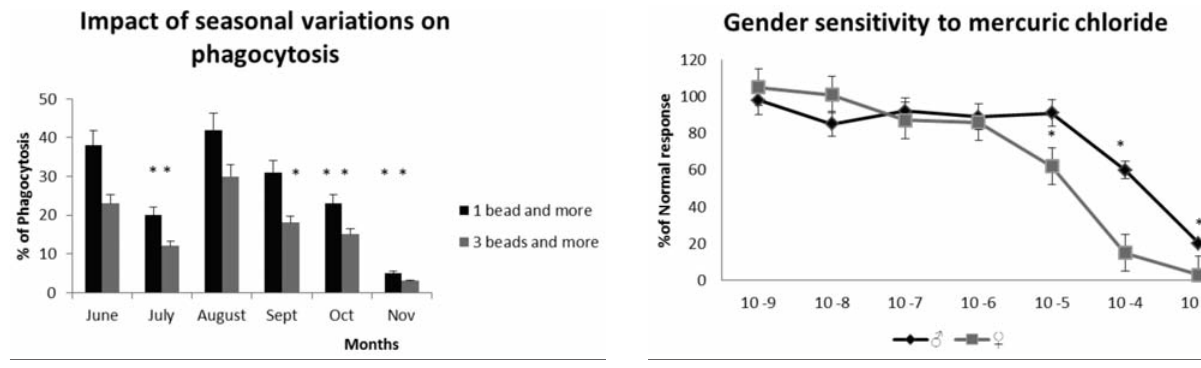
Figure 1. The phagocytic activity of blue mussel is not signifi- cantly different between June and August but significantly lower for the other four months.